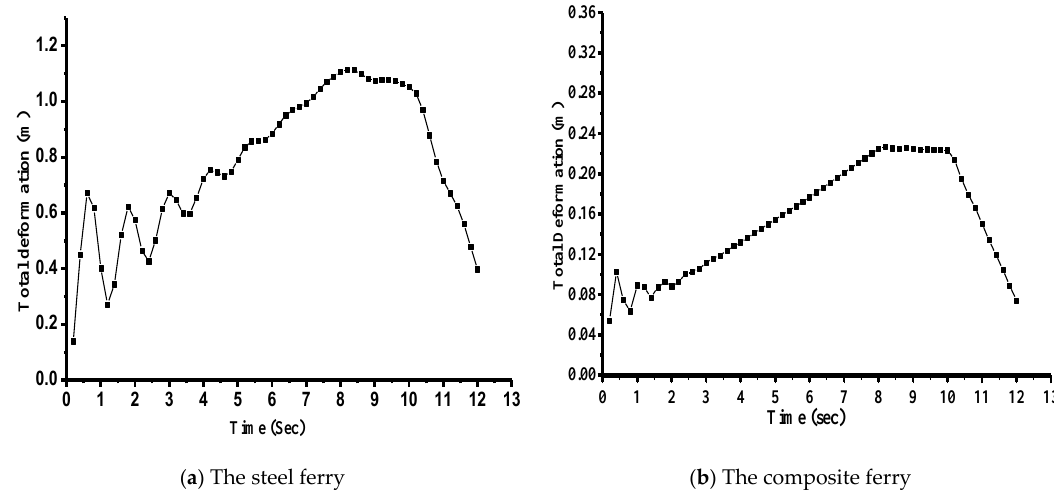
Figure 19. The total deformation distribution in case of loading 1.